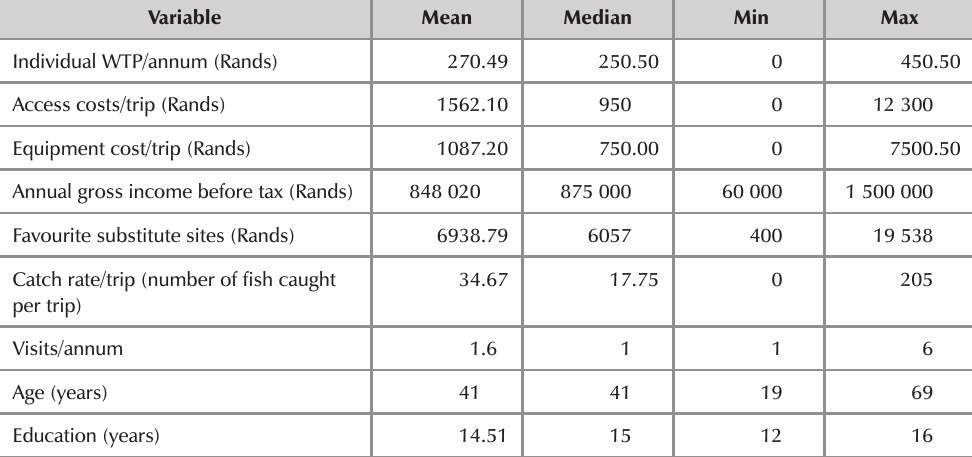
Observed mean, median, minimum and maximum values of the dependent variable and continuous independent variables Variable